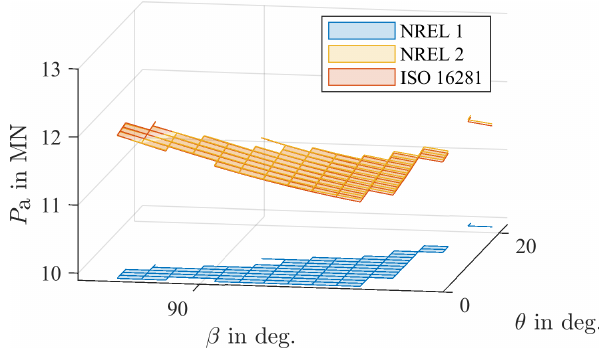
Figure 10. Equivalent loads P a for a fixed pitch angle of θ = 10 ◦ at operating points from the aeroelastic simulations.